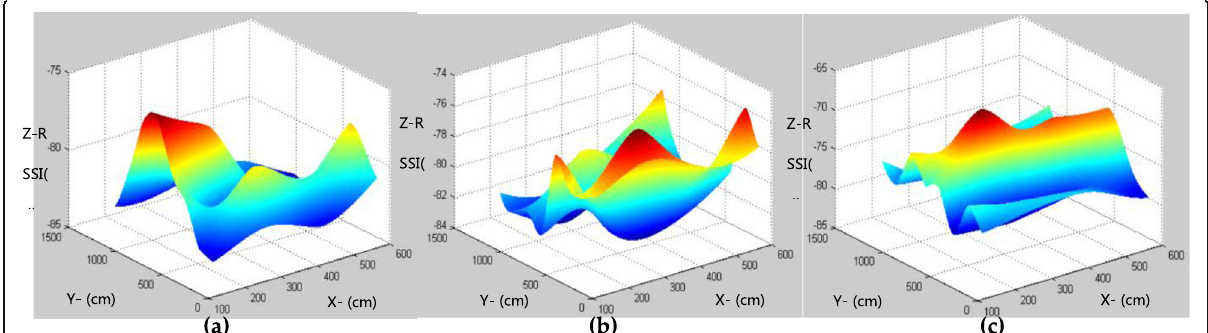
Fig. 1 RSS distributions for three different APs in the same space. a The RSS value received from the AP 1 at the RP i . b The RSS value received from the AP 2 at the RP i . c The RSS value received from the AP 3 at the RP